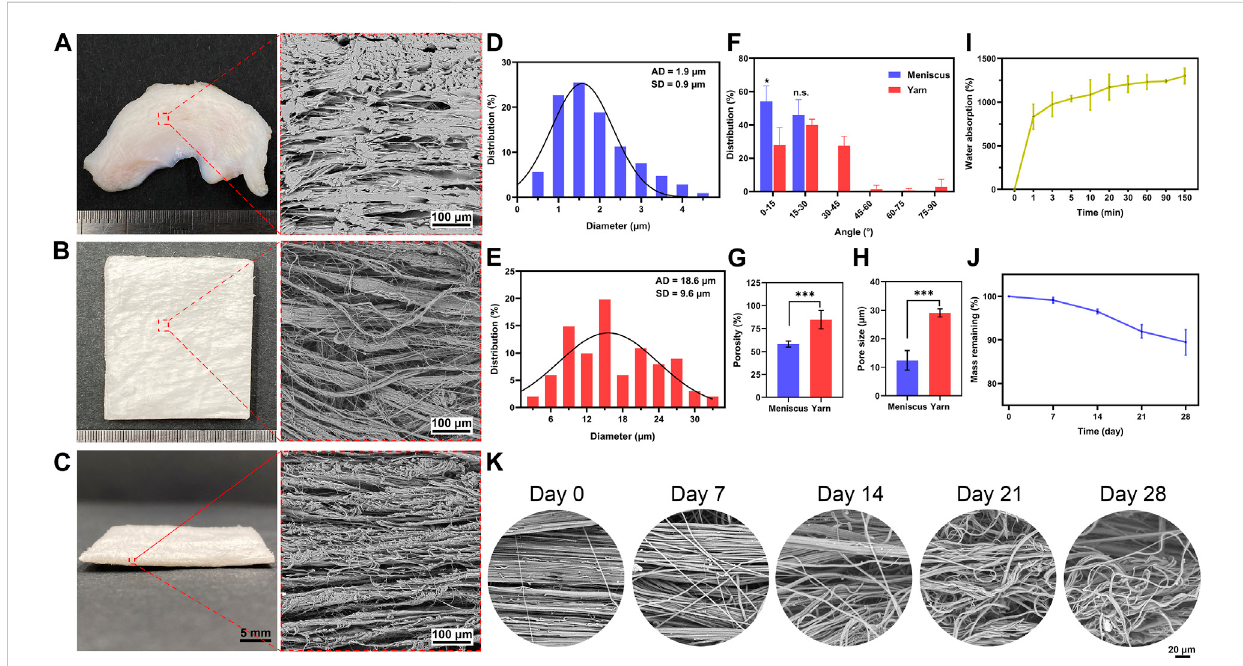
FIGURE 1 Physicochemical properties of electrospun nano fi ber yarn scaffold. The native meniscus shows dense ultrastructure of hierarchical ECM (A) with an average diameter of approximately 2 µm (D) and a fi ber angle distribution of 0 – 30 ° (F) . SEM images (B, C) reveal that the scaffold exhibits aligned fi ber yarns with an average diameter of approximately 20 µm (E) and fi ber angle distribution of 0 – 30 ° (F) , which resemble the hierarchical ECM of the native meniscus. Thescaffold hasahigherporosity (G) andporesize (H) thanthenative meniscus. Thescaffold shows1,300% waterabsorption (I) .Despite a10%weightlossafter28 daysof invitro incubation (J) ,itshowssigni fi cantmorphologychangethataligned fi bersbecomeswollen fi berswithcoils (K) .* p < 0.05, *** p <